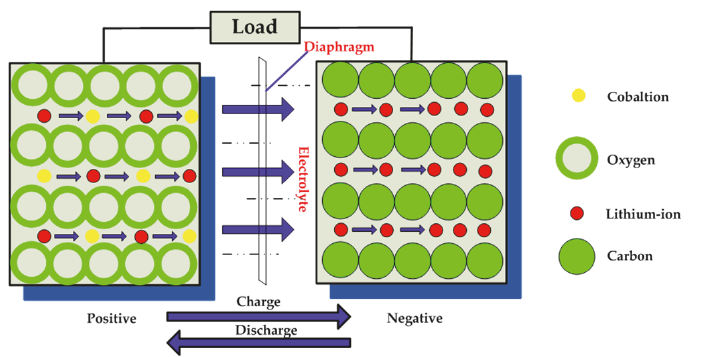
Figure 1: Lithium battery charge and discharge microscopic diagram.